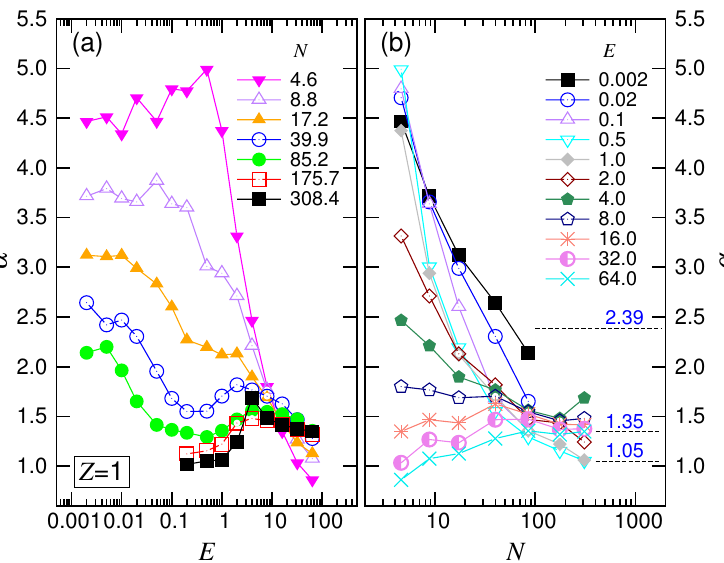
Figure 7. Exponent α ( a ) as a function of E at different N and ( b ) as a function of N for different E , in the monovalent salt solution. The values of N in the plots are the geometric means of the adjacent N pairs given in the legend of Figure